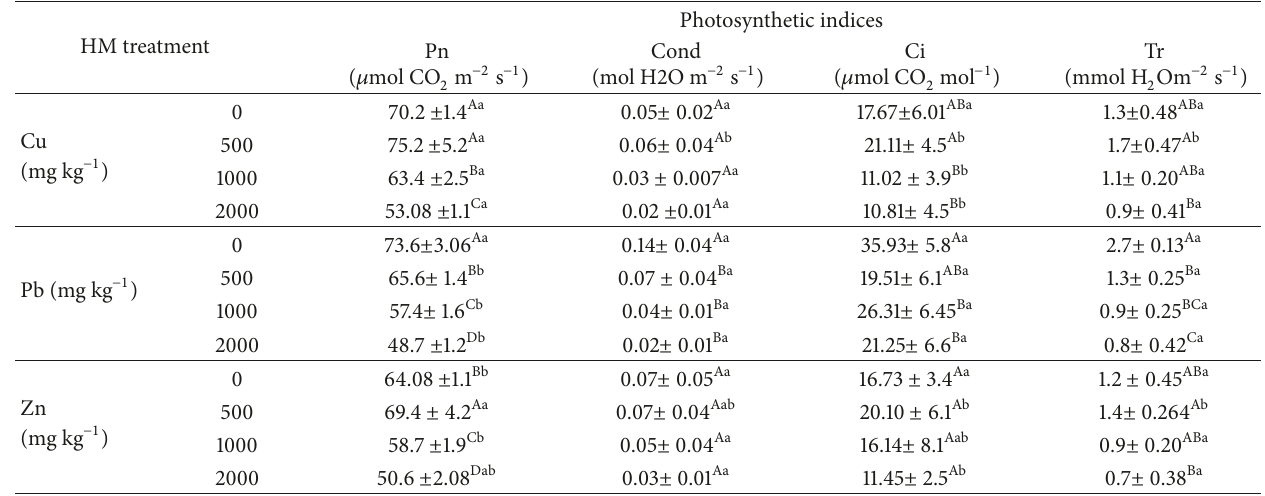
Table 2: Photosynthetic indices of Indocalamus latifolius as affected by HMs